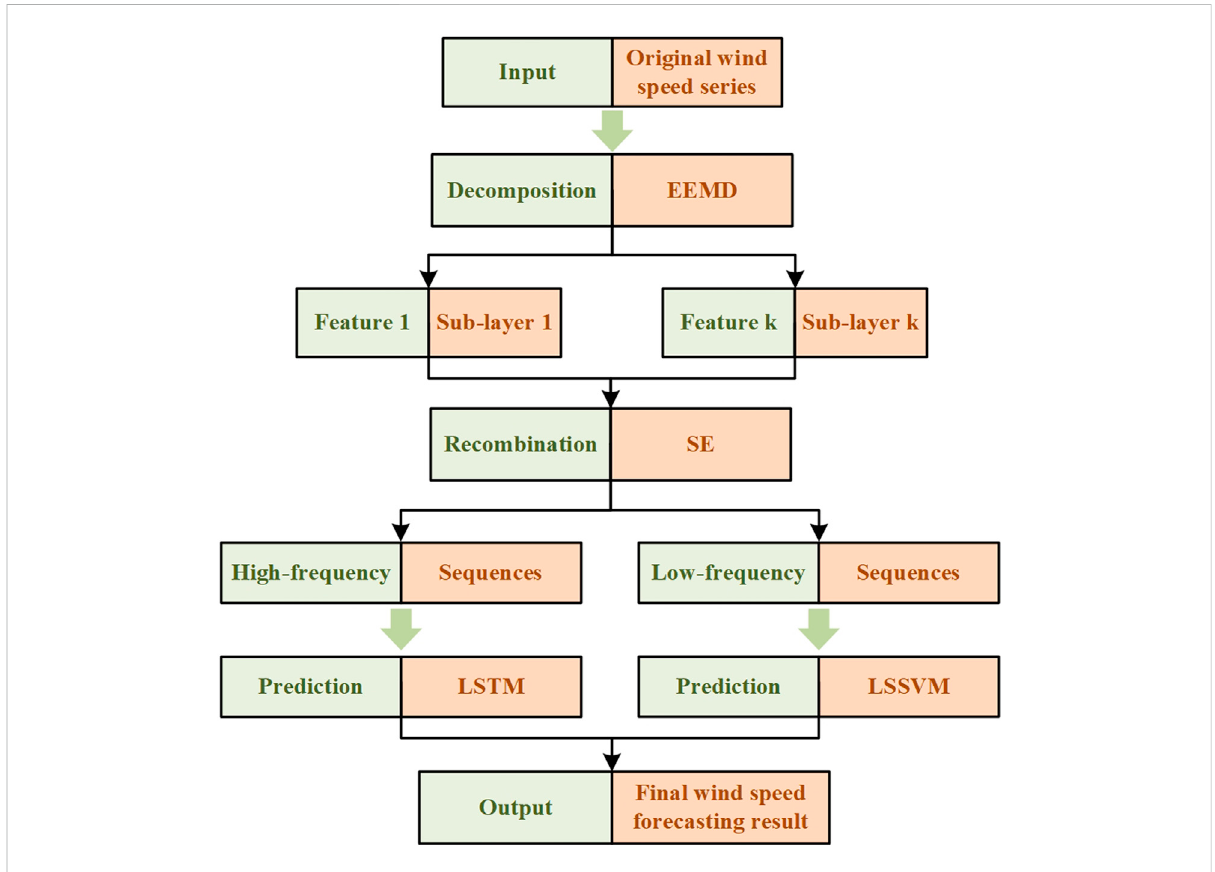
FIGURE 1 Flowchart of the EEMD-LSTM-LSSVM